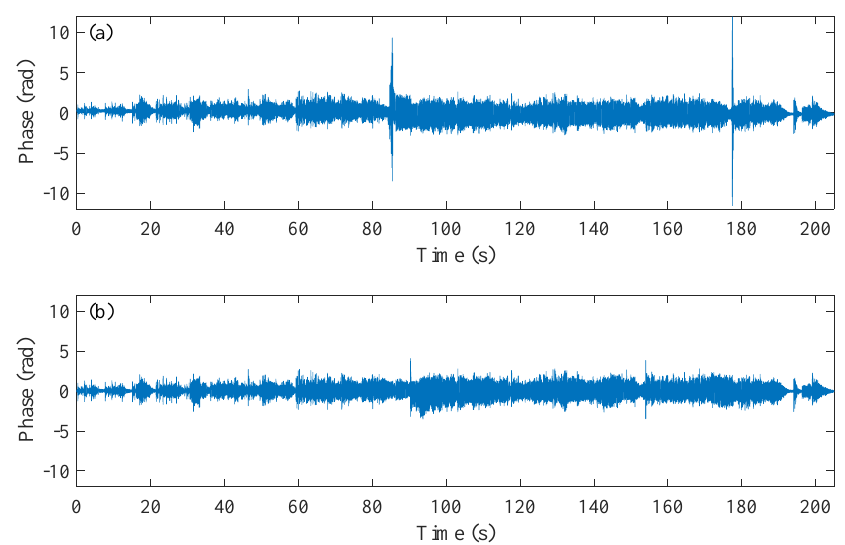
Figure 13. The plot of the retrieved sound signals. ( a ) the retrieved phase signal without WCSA; ( b ) the retrieved phase signal with WCSA.